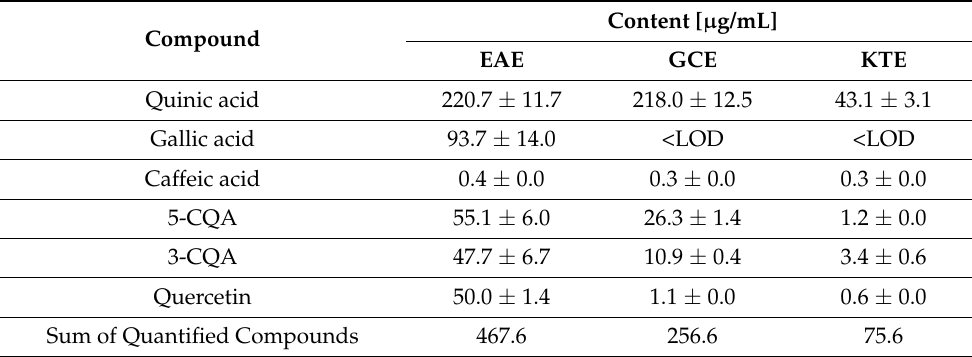
Table 2. Quantification results obtained for Epilobium angustifolium L. (EAE), Centella asiatica L. (GCE) and Clitoria ternatea L. (KTE) extracts.Values are means ± SD of triplicate. Content [ µ Compound